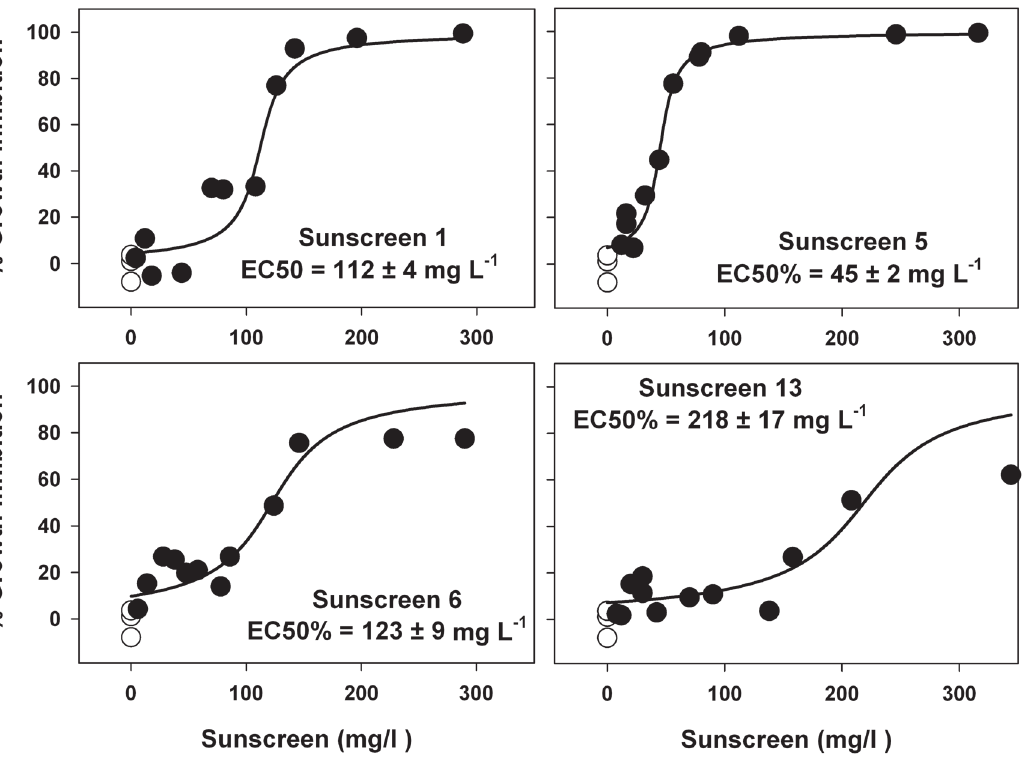
Figure 4. Growth inhibition rate for Chaetocerosgracilis exposed to different concentrations of commercial sunscreens after 72 hours culture. White circles represent controls.